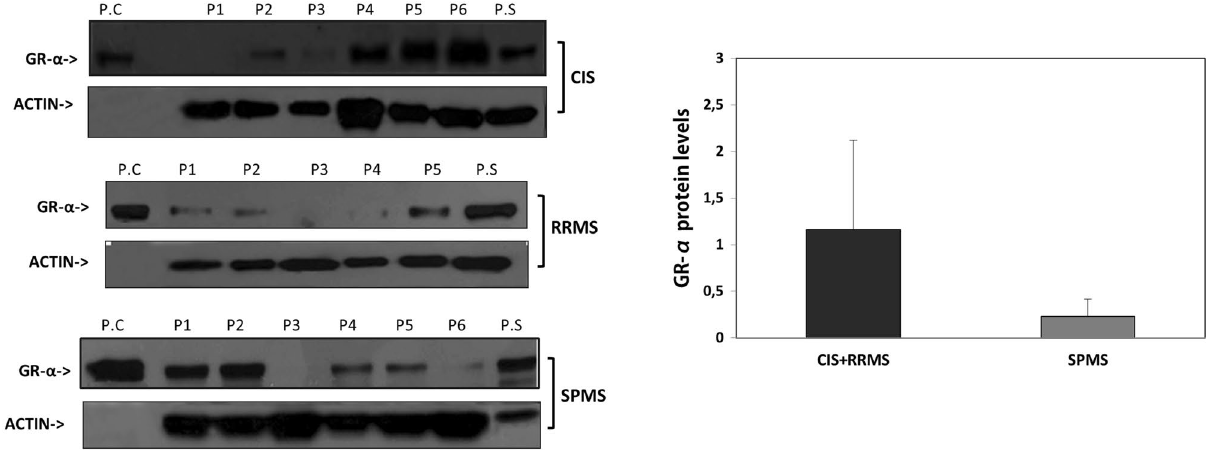
Figure 3. Glucocorticoid Receptor protein levels in MS patients. The GR-α Protein levels were marginally significantly higher in the group of CIS and RRMS patients compared to SPMS patients ( p = 0.069). No GR-β protein was detected by Western blotting in our samples. No GR-β protein was detected by Western blotting in our experimental conditions. To evaluate the protein level of glucocorticoid receptor (GR) by western blot, 6 patients from each MS subgroups were randomly selected. A positive control lysate (COS cells transfected with GR-α) was used to demonstrate the specificity of the antibody for GR-α and for the recognition of the appropriate band size. Data are shown as mean ± SD (* P <